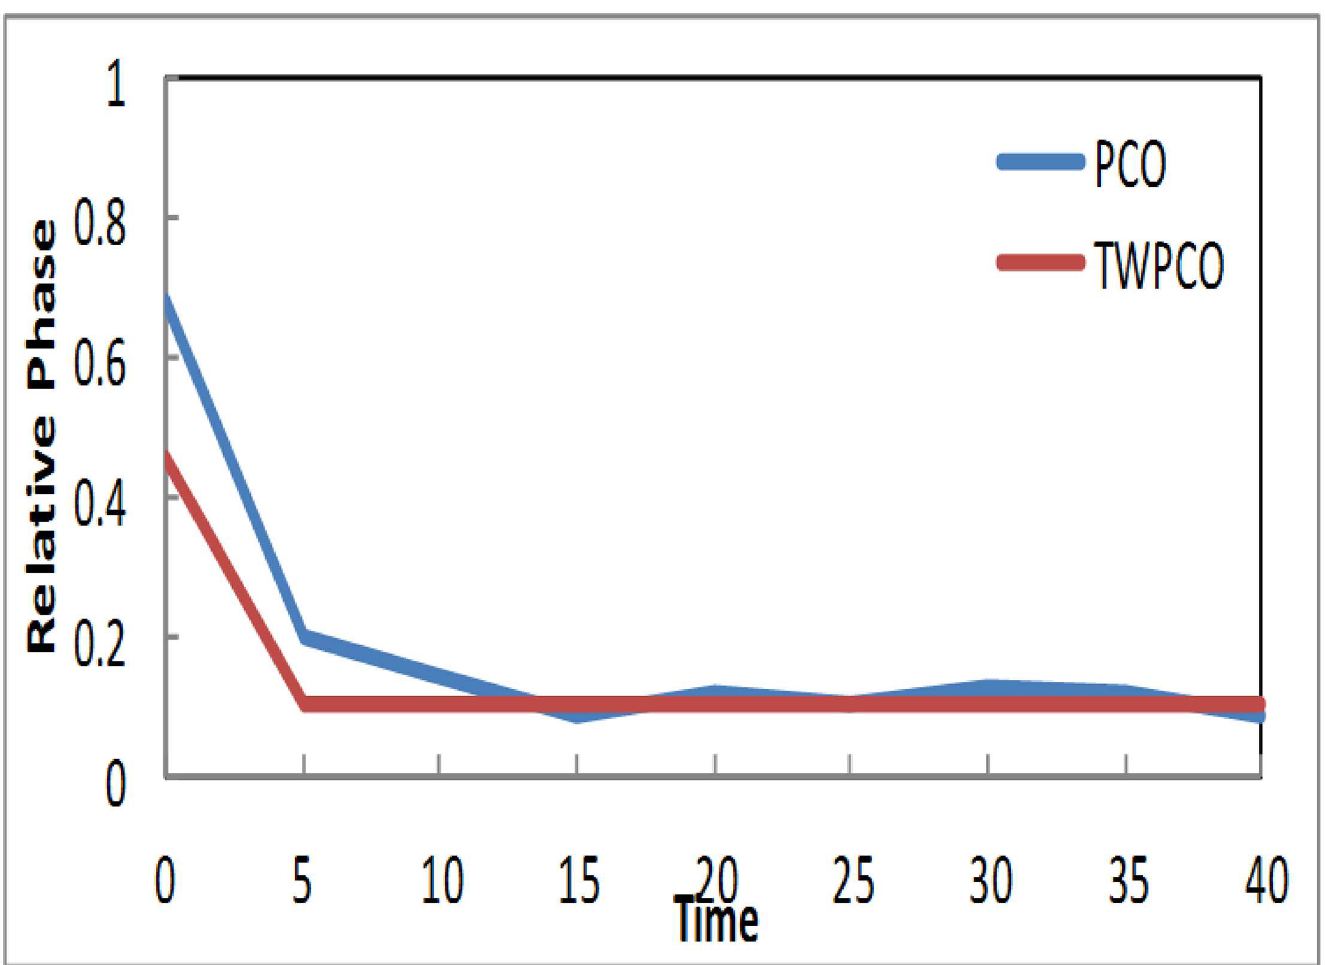
Fig 9. Relative Phase of Sensor TWPCO and PCO in regard to Node